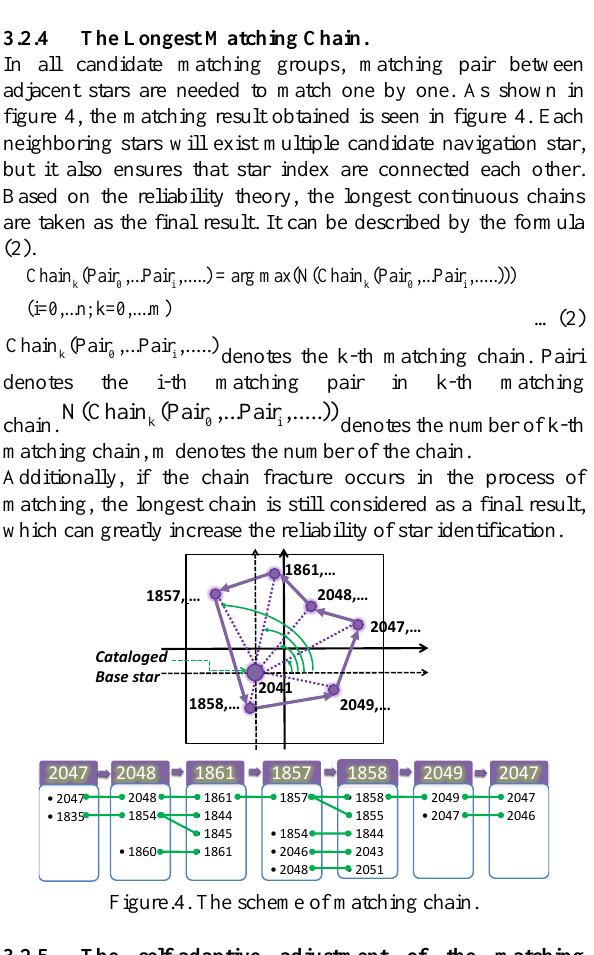
Table 4 Data structure table of ring pattern.